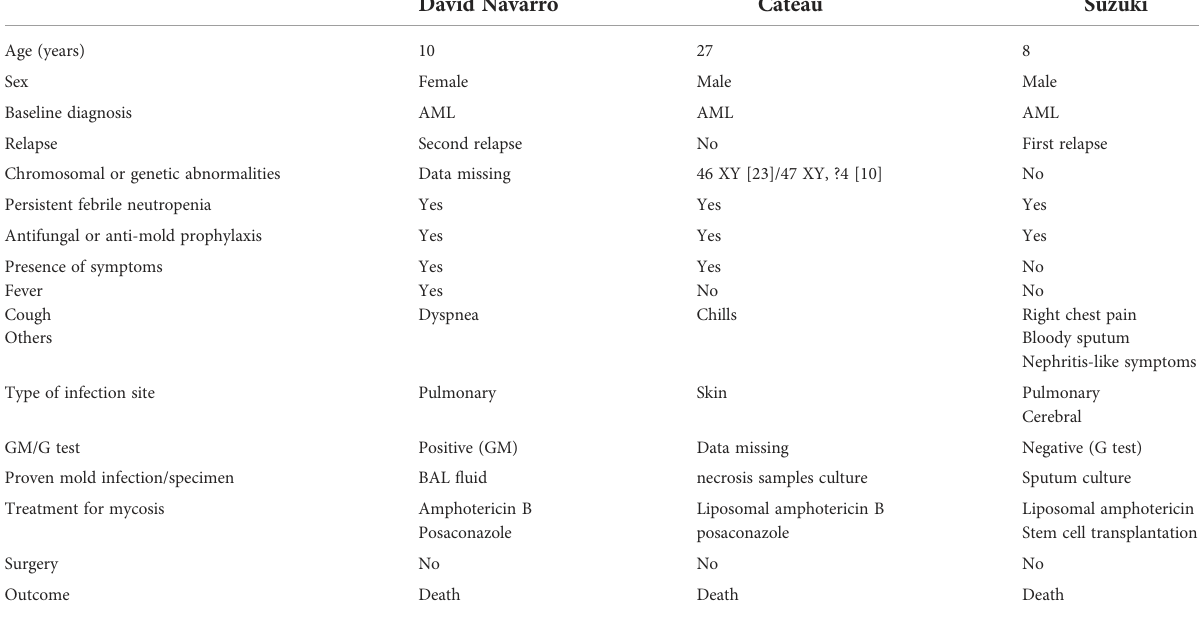
TABLE 2 Lichtheimia ramosa -related mucormycosis based on available case